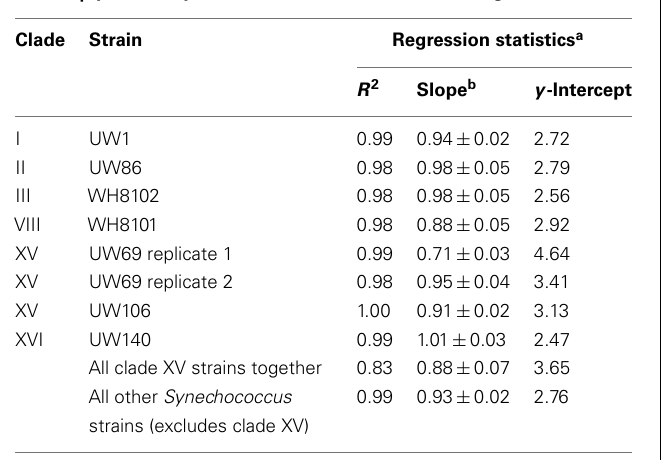
Table 2 | qPCR assay calibration curve statistics (see Figure 2).